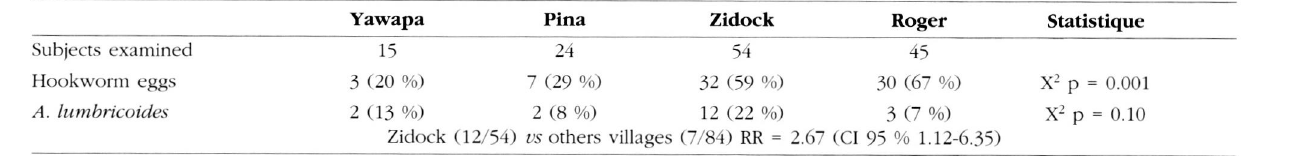
Table III. - Prevalence of hookworm and Ascaris lumbricoides infection according to village. Yawapa Pina